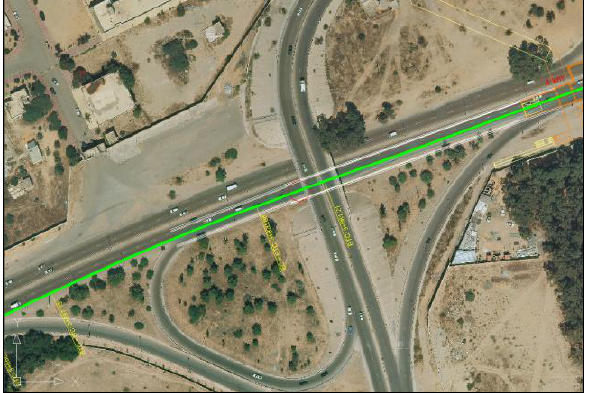
Figure 8. During construction only half of the highway will be closed